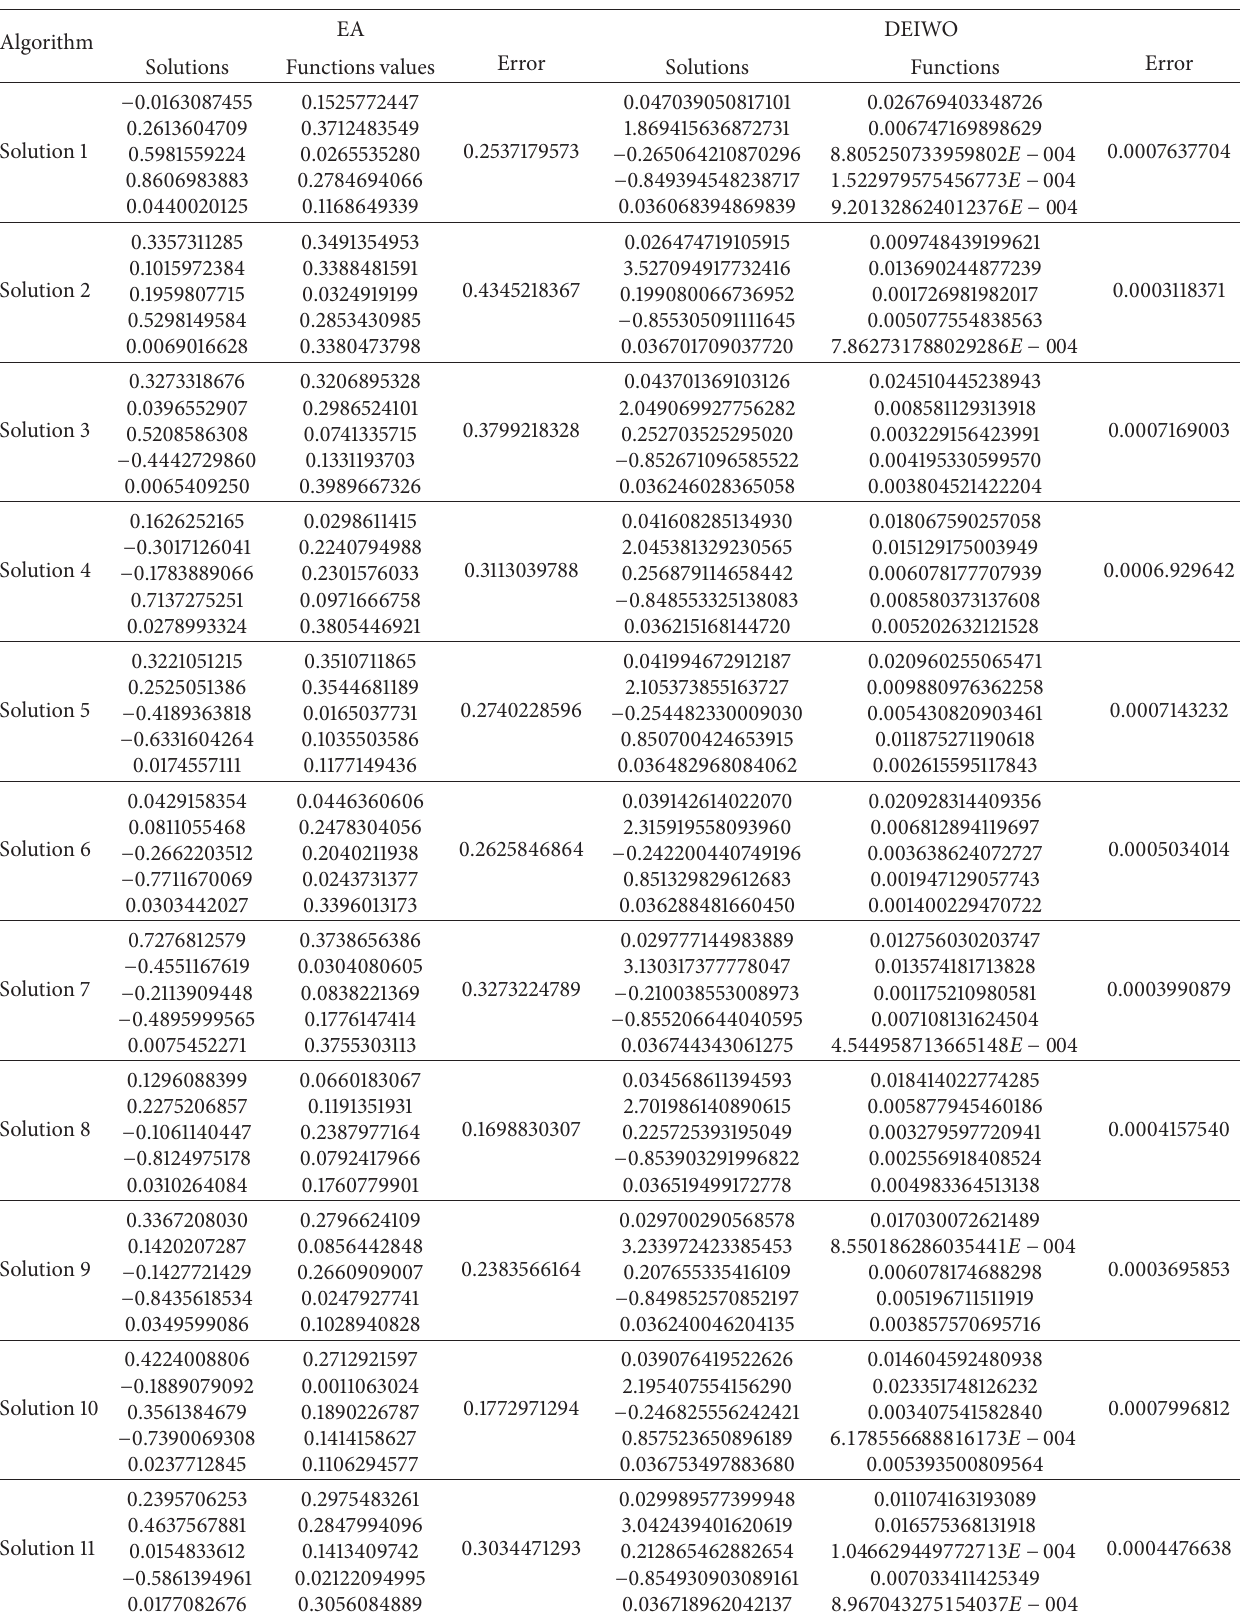
Table 8: Comparison of results for chemical equilibrium application